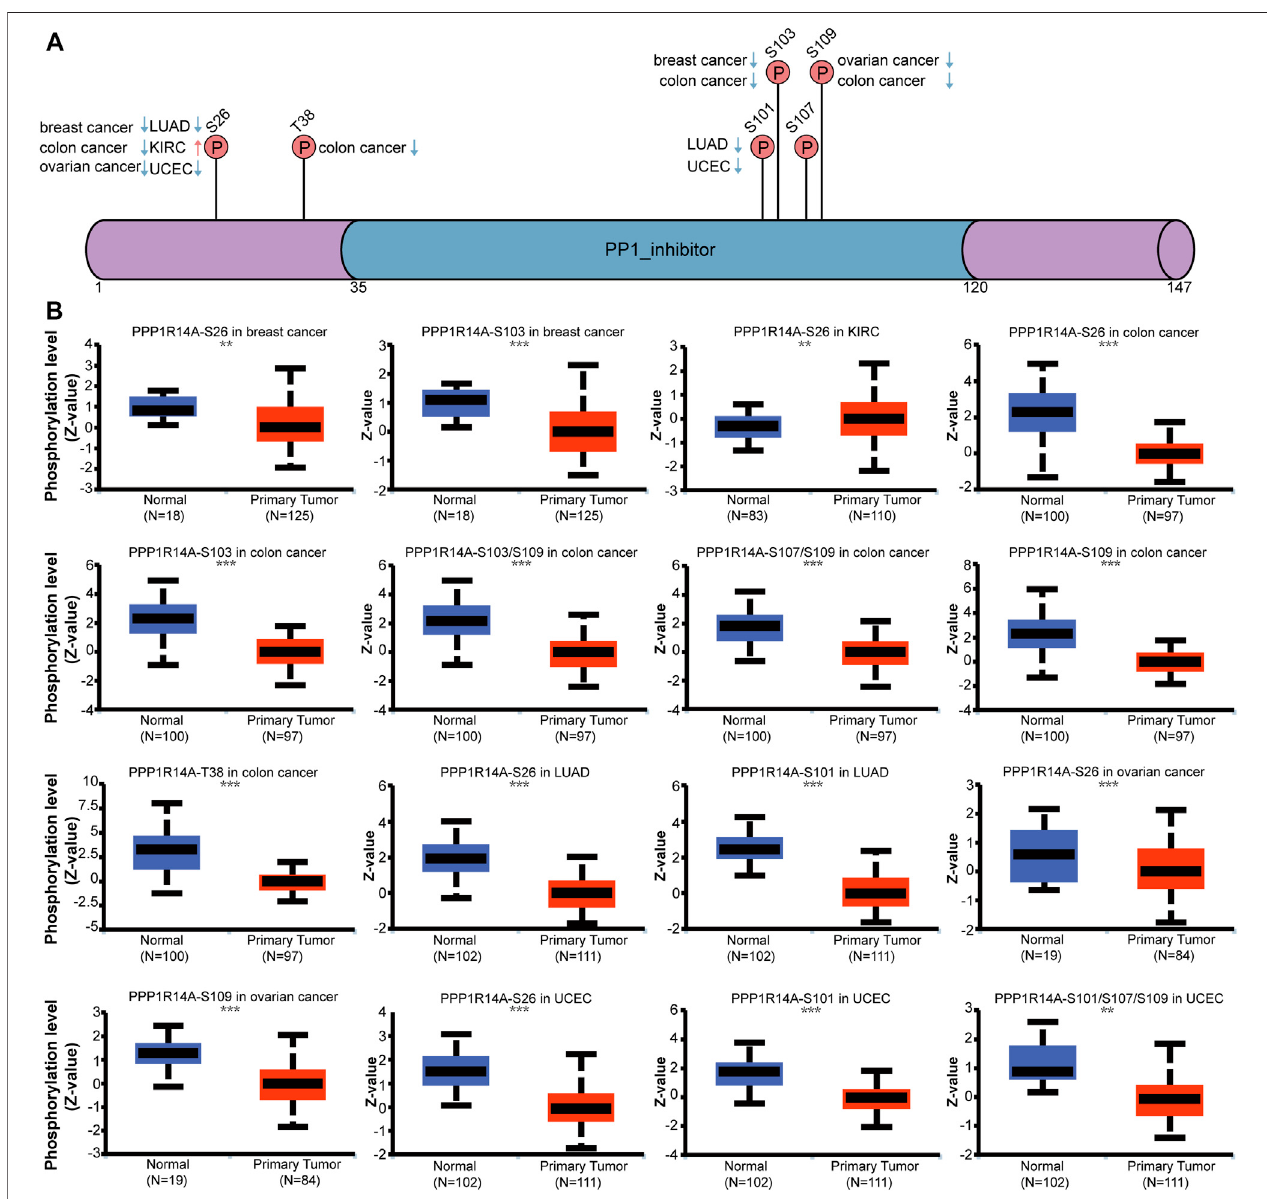
FIGURE 10 | Phosphorylation of PPP1R14A in several selected cancers according to the CPTAC database. The schematic diagram and phosphorylation sites of the PPP1R14A protein are shown (A) . Phosphorylation of PPP1R14A at S26, S101, S101/S107/S109, S103, S103/S109 S107/S109, S109, and T38 was analyzed in breast cancer, clear cell RCC, colon cancer, LUAD, ovarian cancer, and UCEC (B) . pp , p < 0.01; ppp , p <